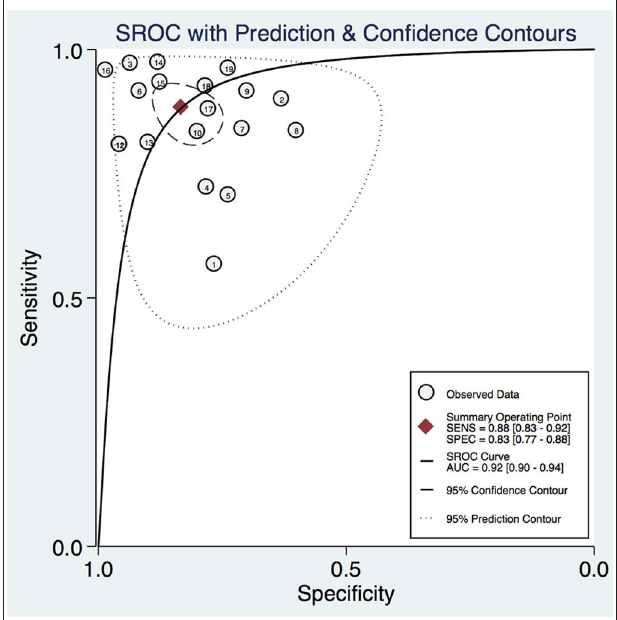
FIGURE 4 | Summary receiver operating characteristic (SROC) curve.